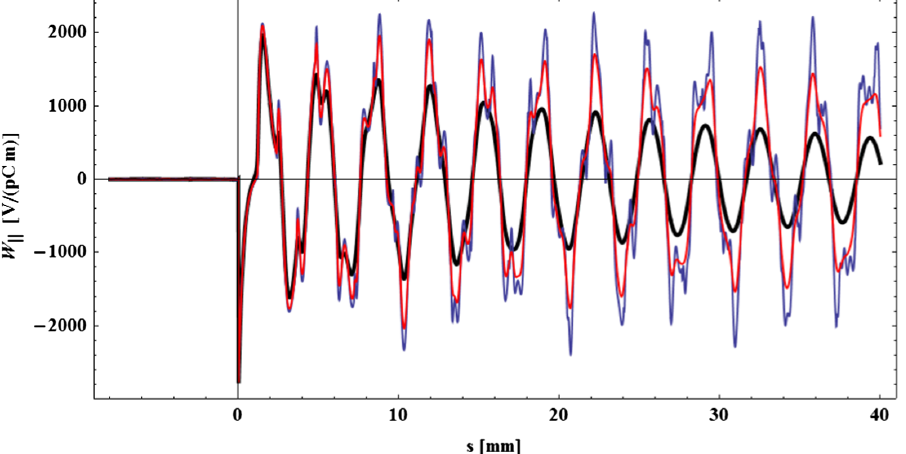
FIG. 5. Longitudinal monopole wake function of the considered bilayer metal-dielectric structure at various values of ε 00 1 : ε 00 1 ¼ 0 (blue line), ε 00 1 ¼ 0 . 1 (red line), and ε 00 1 ¼ 0 . 5 (black line).